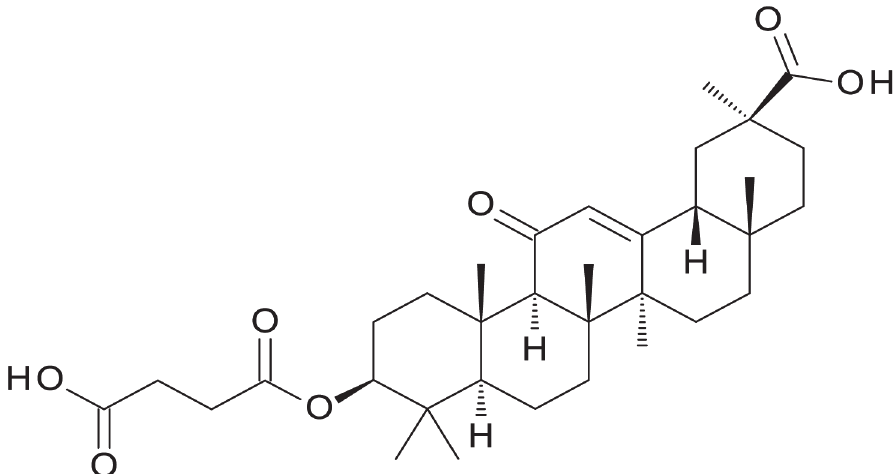
Fig 6. Carbenoxolone, 20nM inhibitor of 11 β